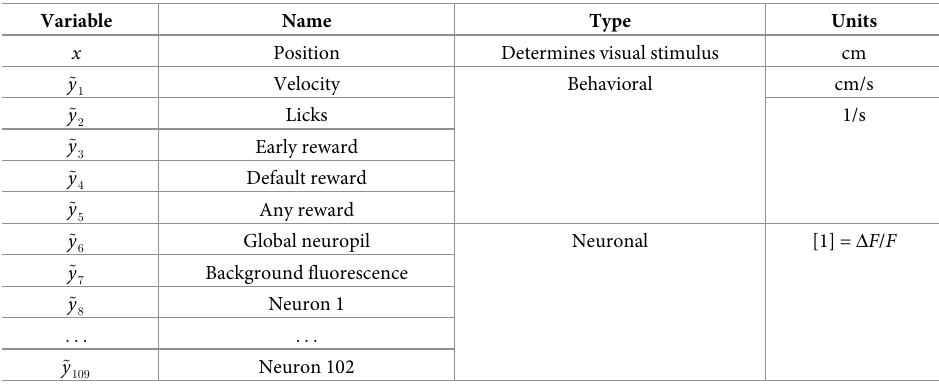
Table 1. A list of variables in the navigational task dataset from Pakan et al.; for a detailed description of the task and the reward, see the original paper [5]. The variables are grouped according to their type; their order ~ y does not correspond to the order of variables y 1 ... y 109 in vine models (see